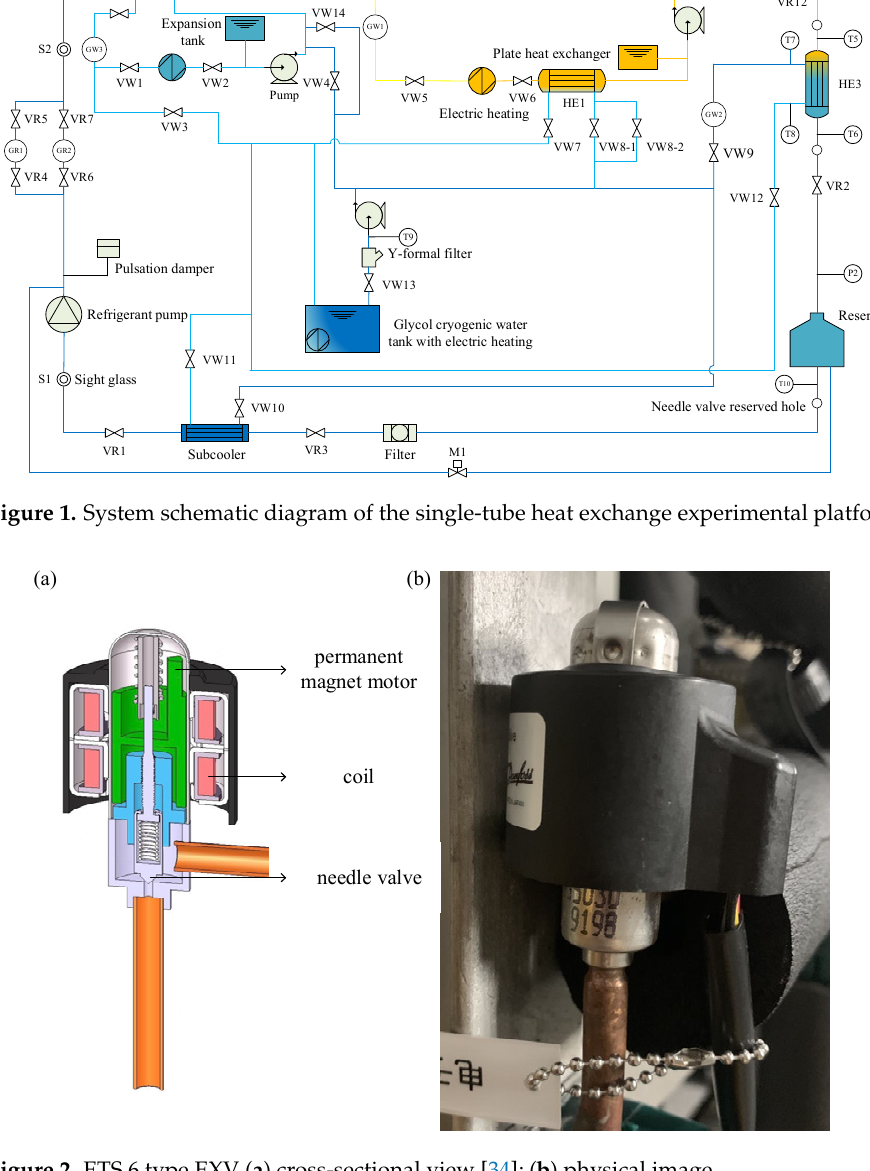
Figure 1. System schematic diagram of the single ‐ tube heat exchange experimental platform [32].